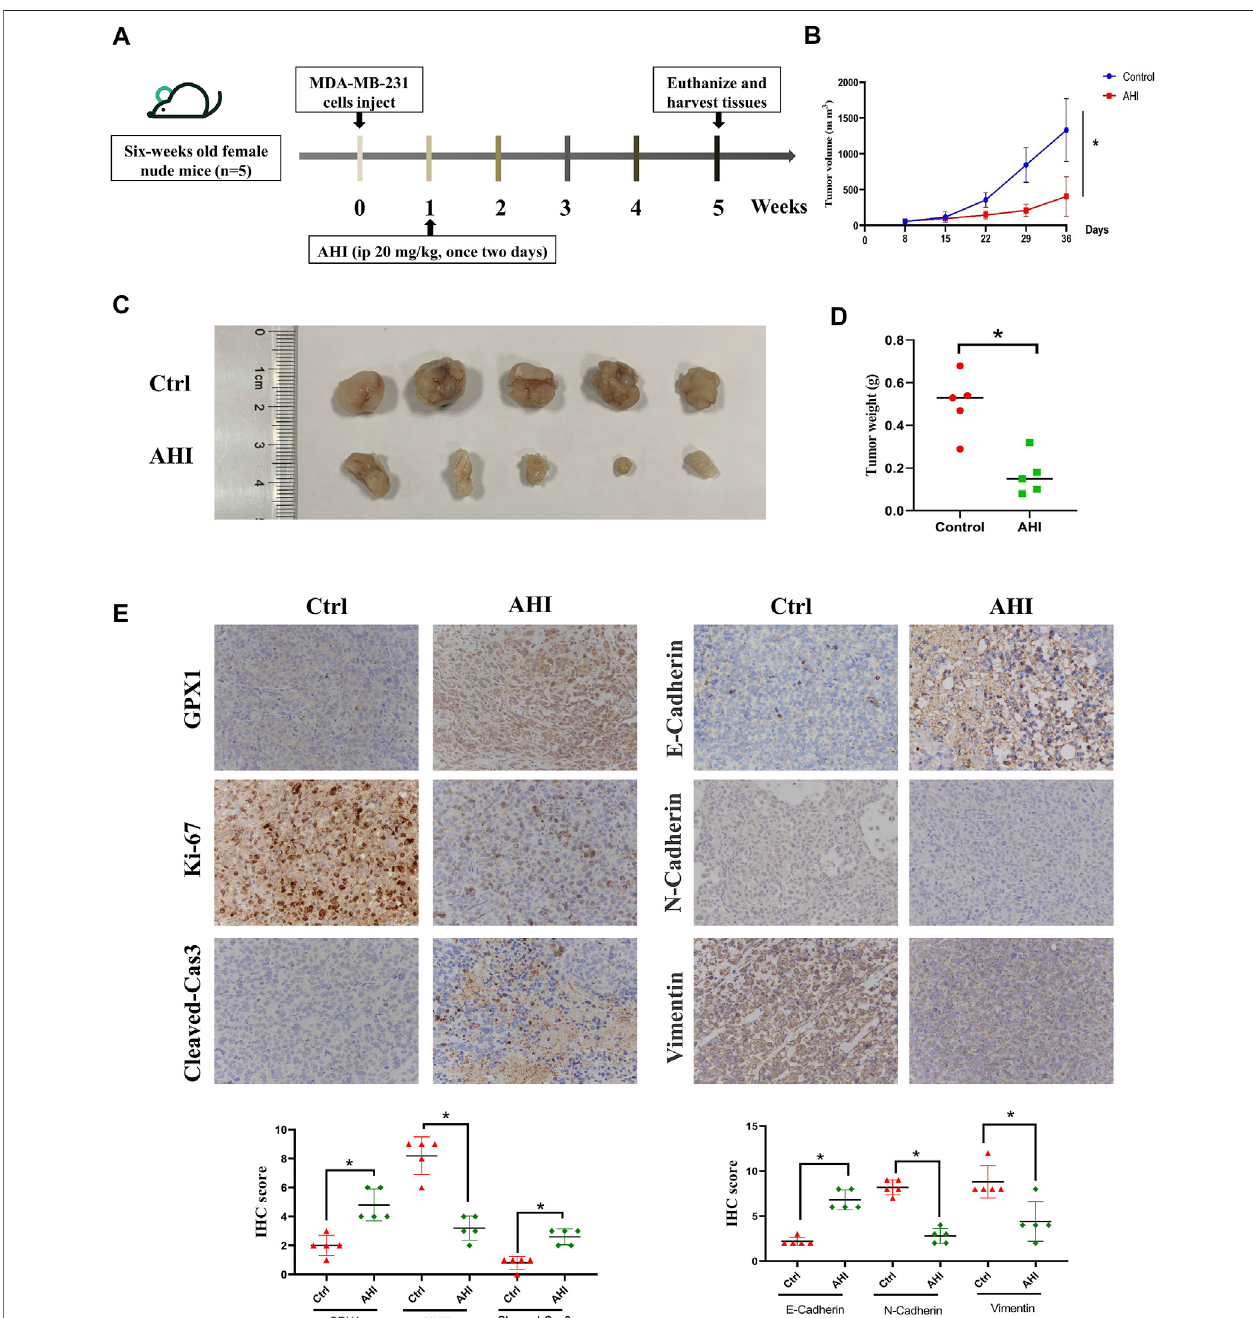
FIGURE 7| AHI enhances GPX1 expression and inhibits EMT in the BC xenograft mouse model. (A) Diagram showing the scheme for tumor implantation and AHI treatment. (B – D) BCproliferationafterAHItreatmentinthemousemodel. (E) IHCanalysisofGPX1,proliferation-related,andEMT-relatedproteinsafterAHItreatmentin mice. * p <